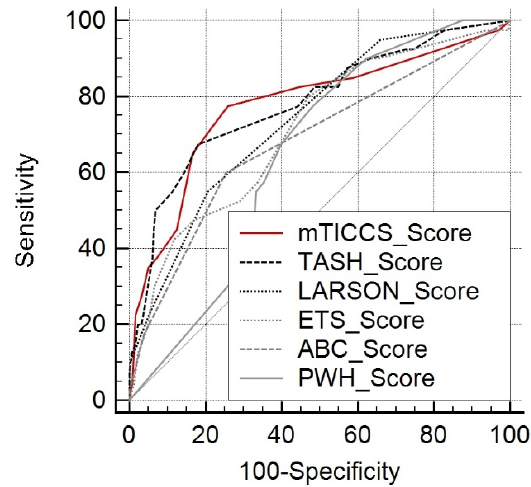
Figure 1. Area under the receiver operating characteristic curves (AUCs) for the mTICCS, Trauma- Associated Severe Hemorrhage (TASH), Assessment of Blood Consumption (ABC), Larson, Prince of Wales Hospital (PWH), and Emergency Transfusion Score (ETS)